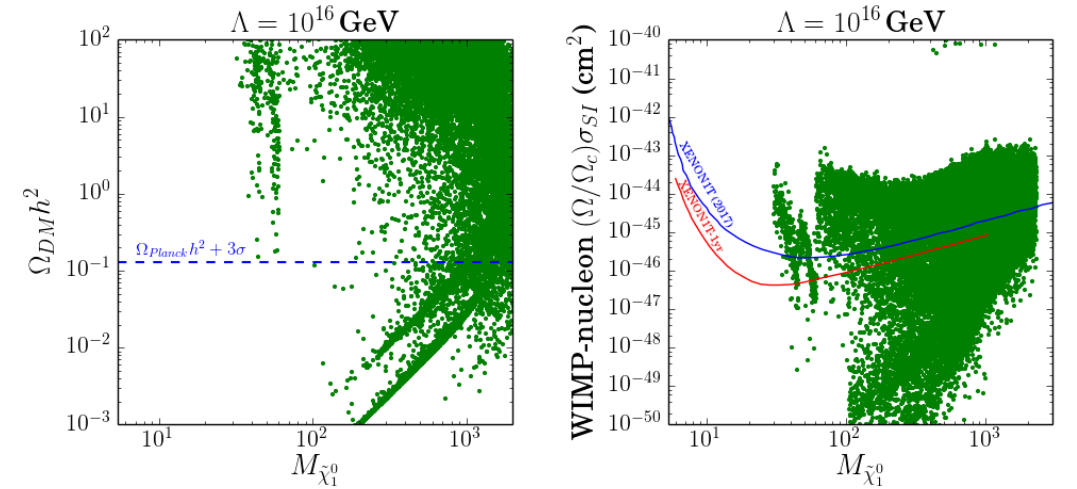
Figure 2 . Left: Relic density (cid:10) DM as a function of the LSP mass corresponding to the red squares in the rightmost panels of (cid:12)gure 1. The dotted line corresponds to the PLANCK measurement of (cid:10) Planck h 2 = 0 : 112 (cid:6) 0 : 006 [18]. Right: WIMP-nucleon spin-independent cross-section as a function of the LSP mass for the points shown in the left panel. Since we allow the LSP to be underabundant after freeze-out, we rescale the cross-section by the factor (cid:10) = (cid:10) c where (cid:10) c = (cid:10) Planck . The solid lines correspond to the XENON1T 2017 [19] and the recent 1 tonne (cid:2) year [20] results. Similar plots exist for (cid:3) = 10 5 and 10 10